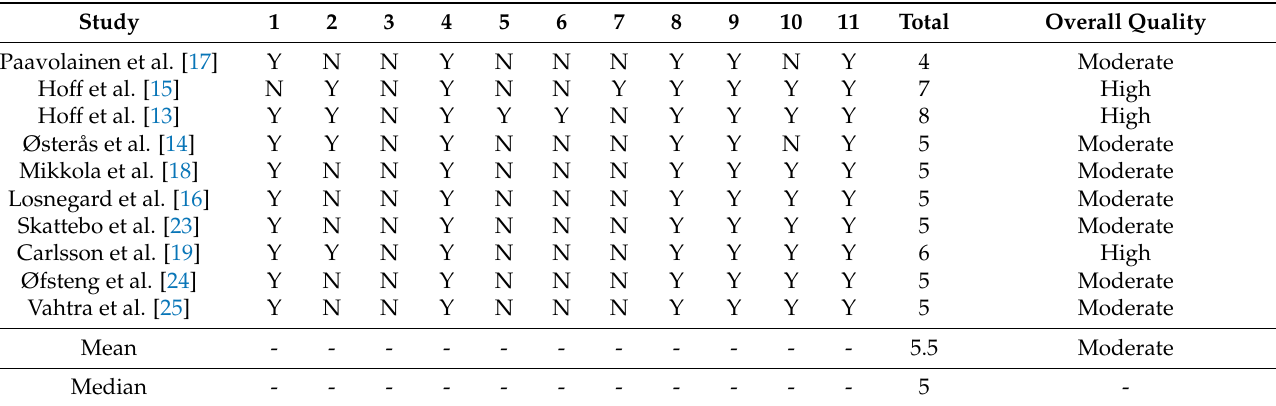
Table 1. Methodological quality assessment using PEDro